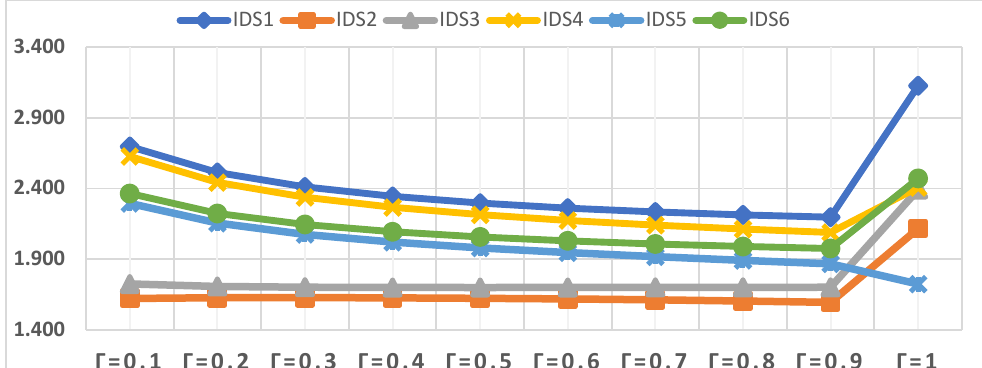
Figure 9. Closeness coefficient values of IDSs in terms of different values of γ .